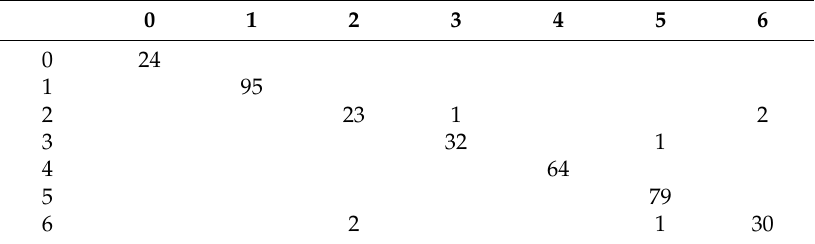
Table A6. The confusion matrix of Figure